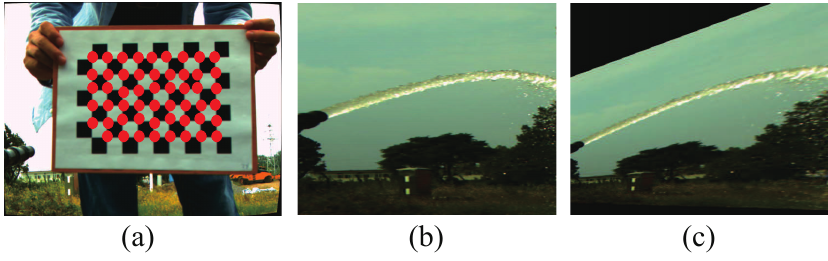
Figure 2. The method of perspective transformation for: ( a ) Corner detection; ( b ) jet trajectory before perspective transformation; ( c ) jet trajectory after perspective transformation.